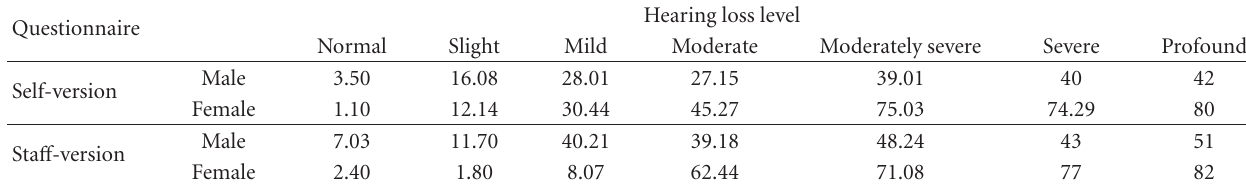
Table 3: Mean values of self-version and sta ff -version (NHHI) ( n = 60).